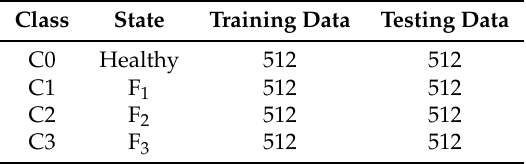
Table 1. Construction of database for fault diagnosis system.